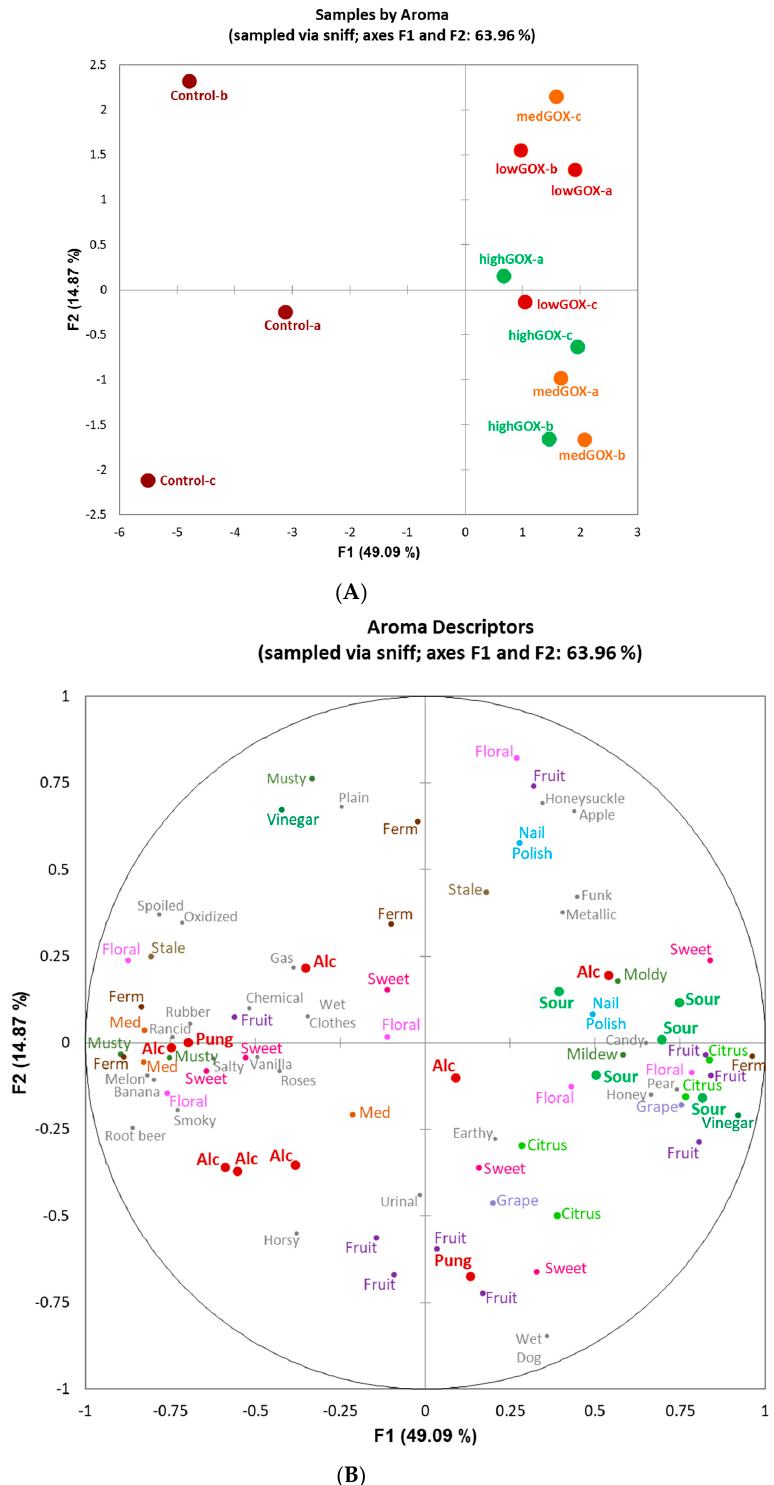
Figure 3. Plots of ( A ) sample consensus space by ( B ) aroma (via sniff) attributes ( A ). Sample consensus space of the untreated (control) samples and GOX-treated samples by level (lowGOX, medGOX, highGOX) and evaluation replicate (a, b, c) resulting from ( B ) aroma characterization by panelists using flash profile via generalized procrustes analysis. Similar colors of attribute words indicate similar aroma notes. Alc = Alcoholic, Ferm = Fermented, Med = Medicinal, Pung =